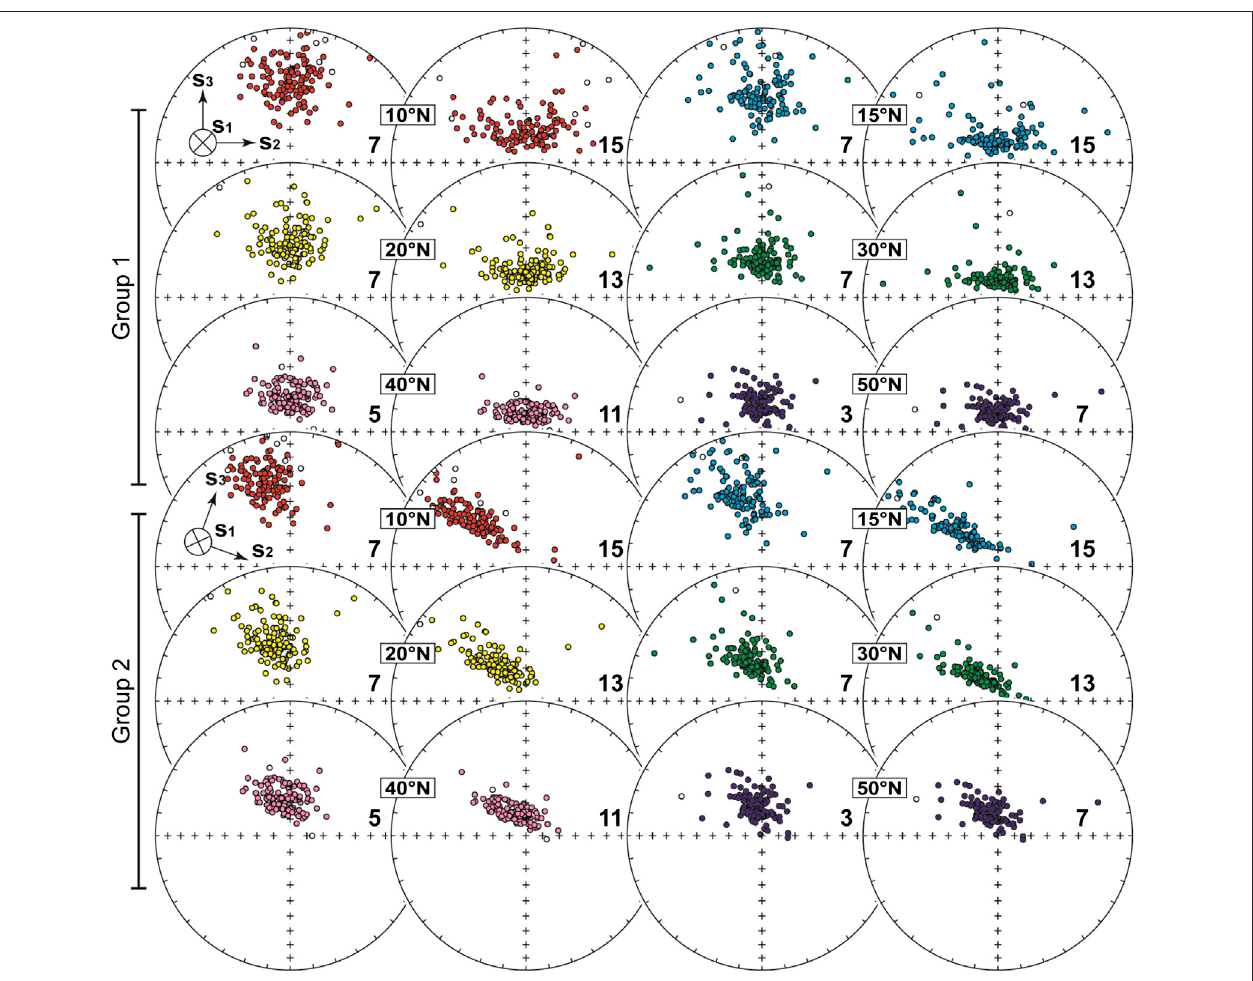
FIGURE 4 | Effect of simulated deformations, without strata tilting, on the TK03.GAD directions datasets. The latitude of the generated dataset is also indicated, and thecolorsofthe data areas in Figure 3 . Group 1and 2correspond respectivelyto aN-S and a20 ° E oriented shortening, asrepresentedby the eigenvectors ofthe strain matrix (S) shown in the insets. The bold numbers inside the projections indicate the S matrix applied to the set, listed in Table 3 .